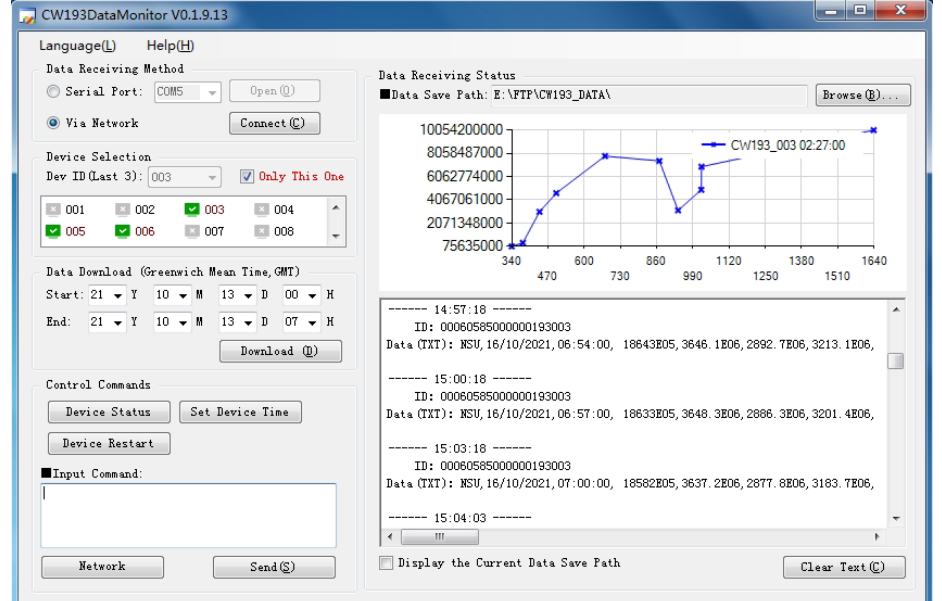
Figure 3. Monitoring software of